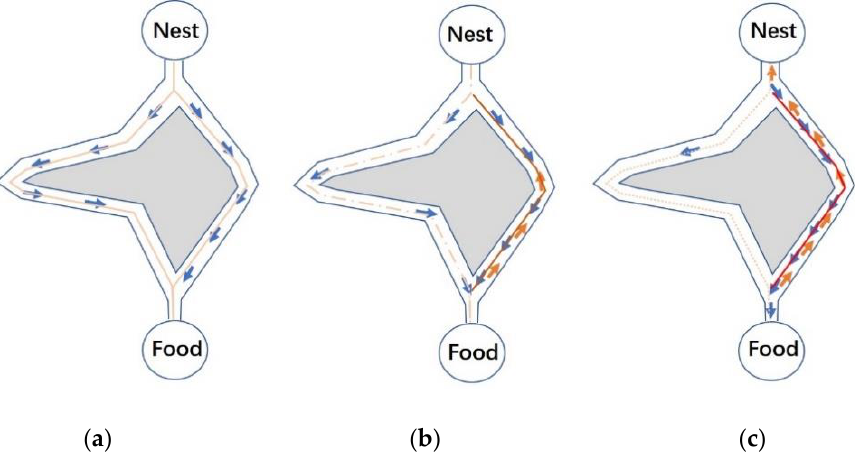
Figure 4. Ant foraging process: ( a ) early path search, ( b ) mid-route search, and ( c ) optimal path.